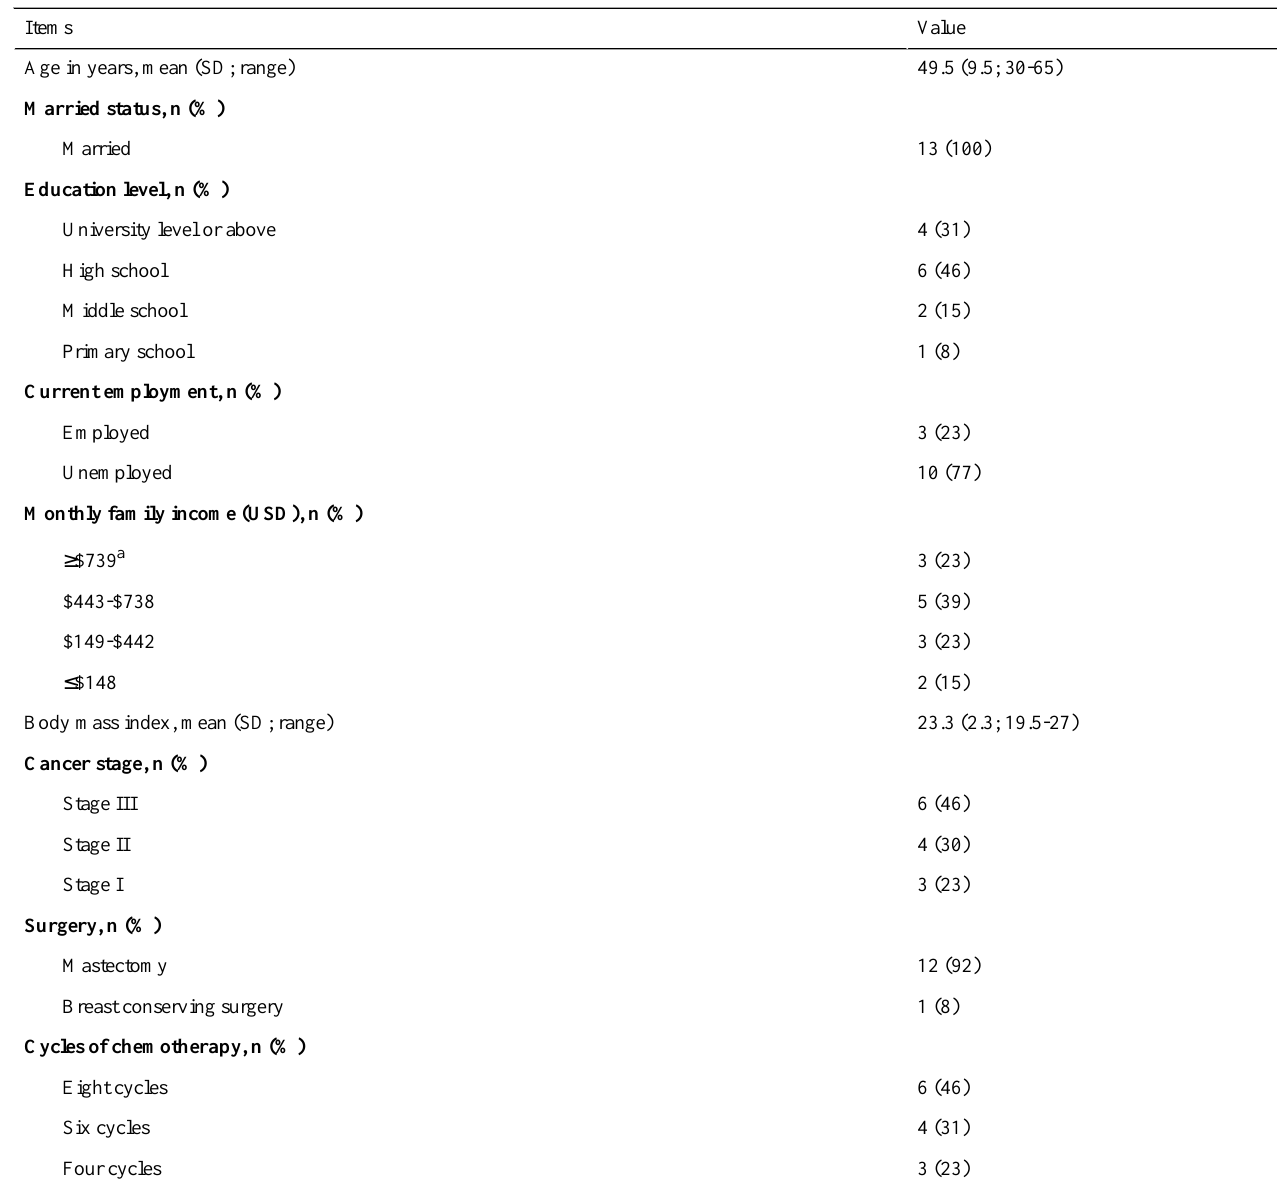
Table 2. Demographic or clinical data of participants in the process evaluation.